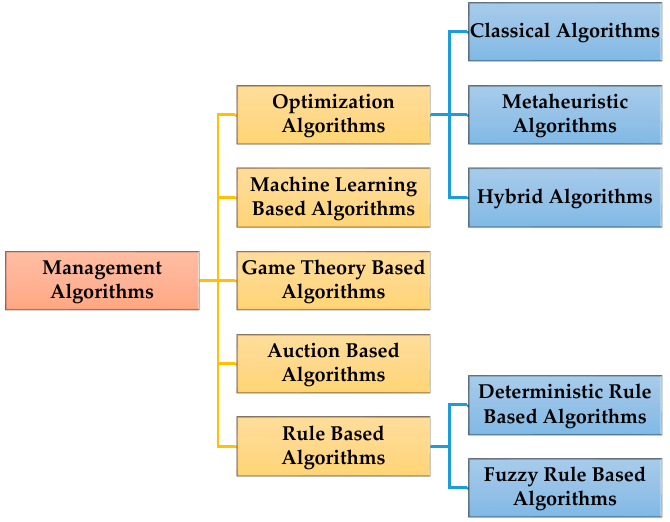
Figure 6. Energy management methods and tools.